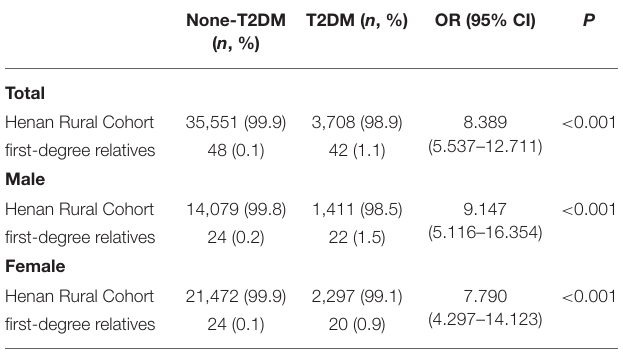
TABLE 2 | The prevalence comparison of T2DM between the first-degree relatives and the Henan Rural Cohort.